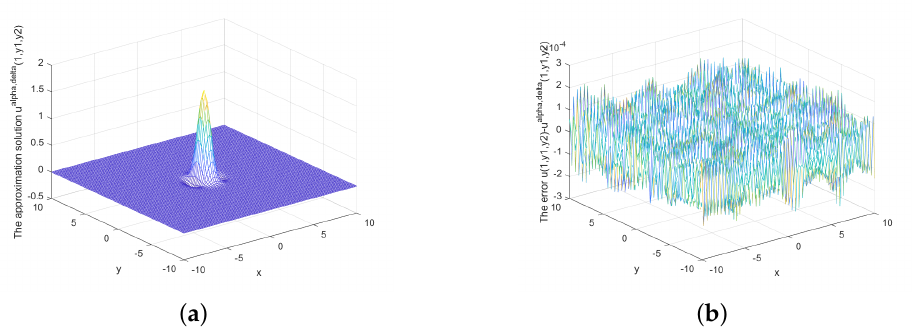
Figure 11. ( a ) The regularized solution and ( b ) error between regularized and exact solution when x = 1, δ = 0.5 × 10 − 8 under the posterior